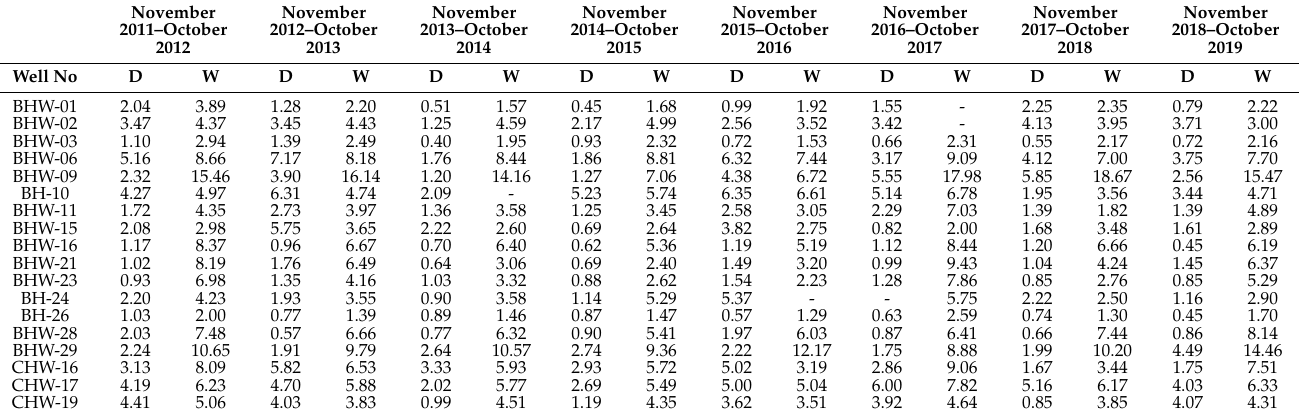
Figure 12. The schematic diagram for the analysis of groundwater level fluctuation potential. Table 2. Statistics of variation of the groundwater level in each monitoring well.